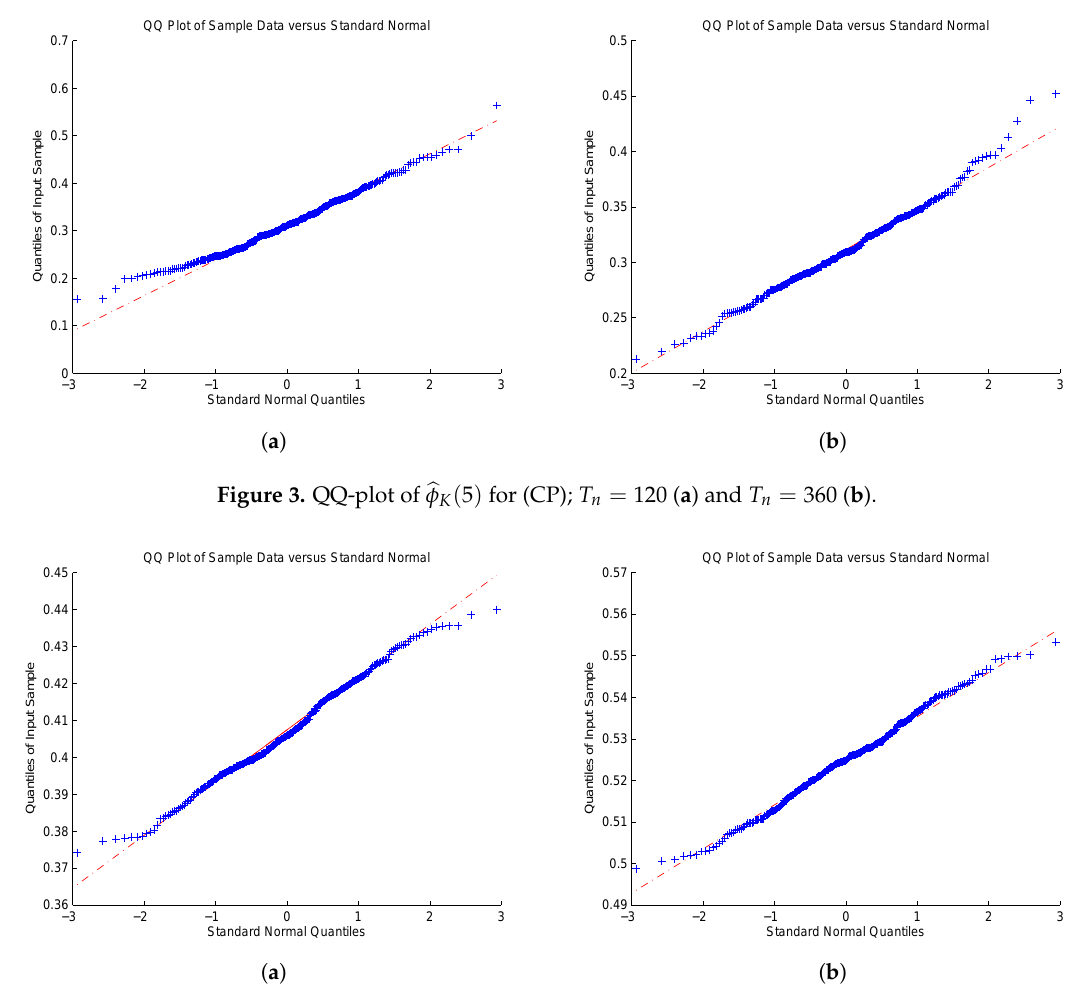
Figure 4. QQ-plot of (cid:98) φ K ( 1 ) for (GS); ( a ) T n = 120, and ( b ) T n = 360.